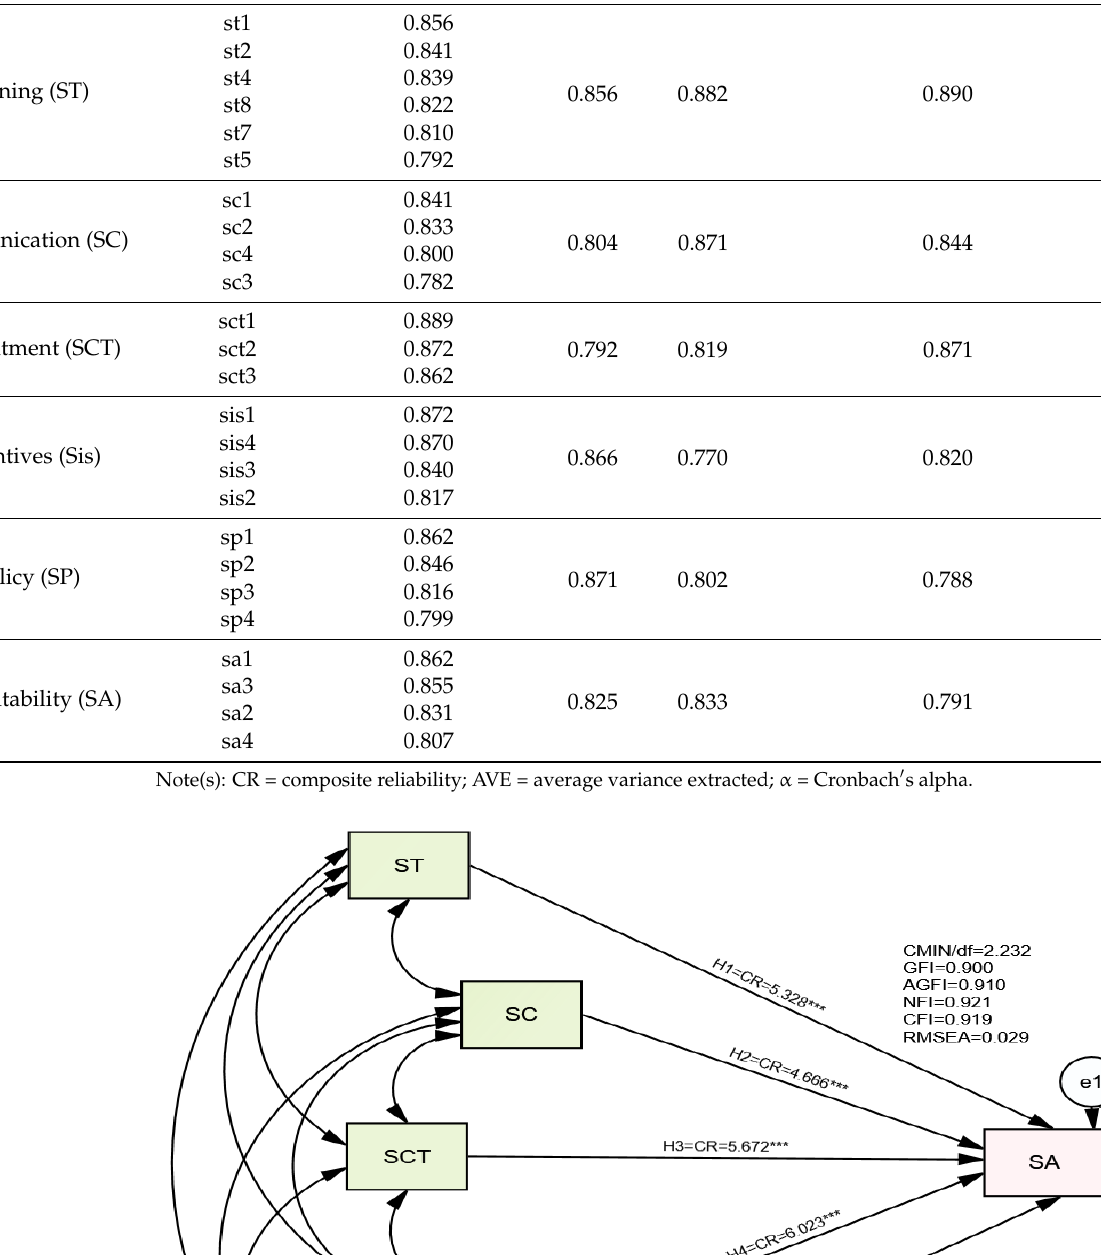
Table 3. Measurement Model.